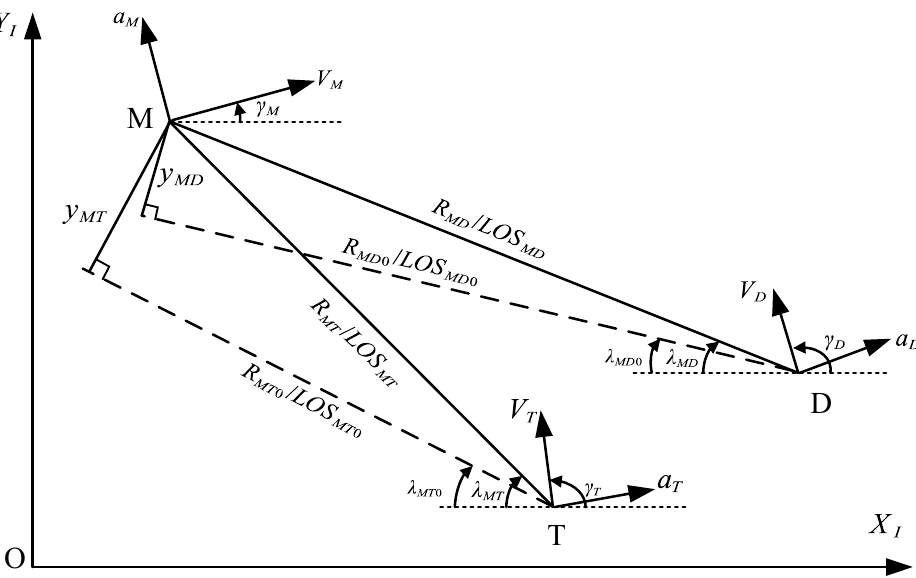
Figure 1. Three ‐ body confrontation engagement geometry. Figure 1. Three-body confrontation engagement geometry. As shown in Figure 1, the nonlinear engagement model of missile-target and missile- defender can be represented as